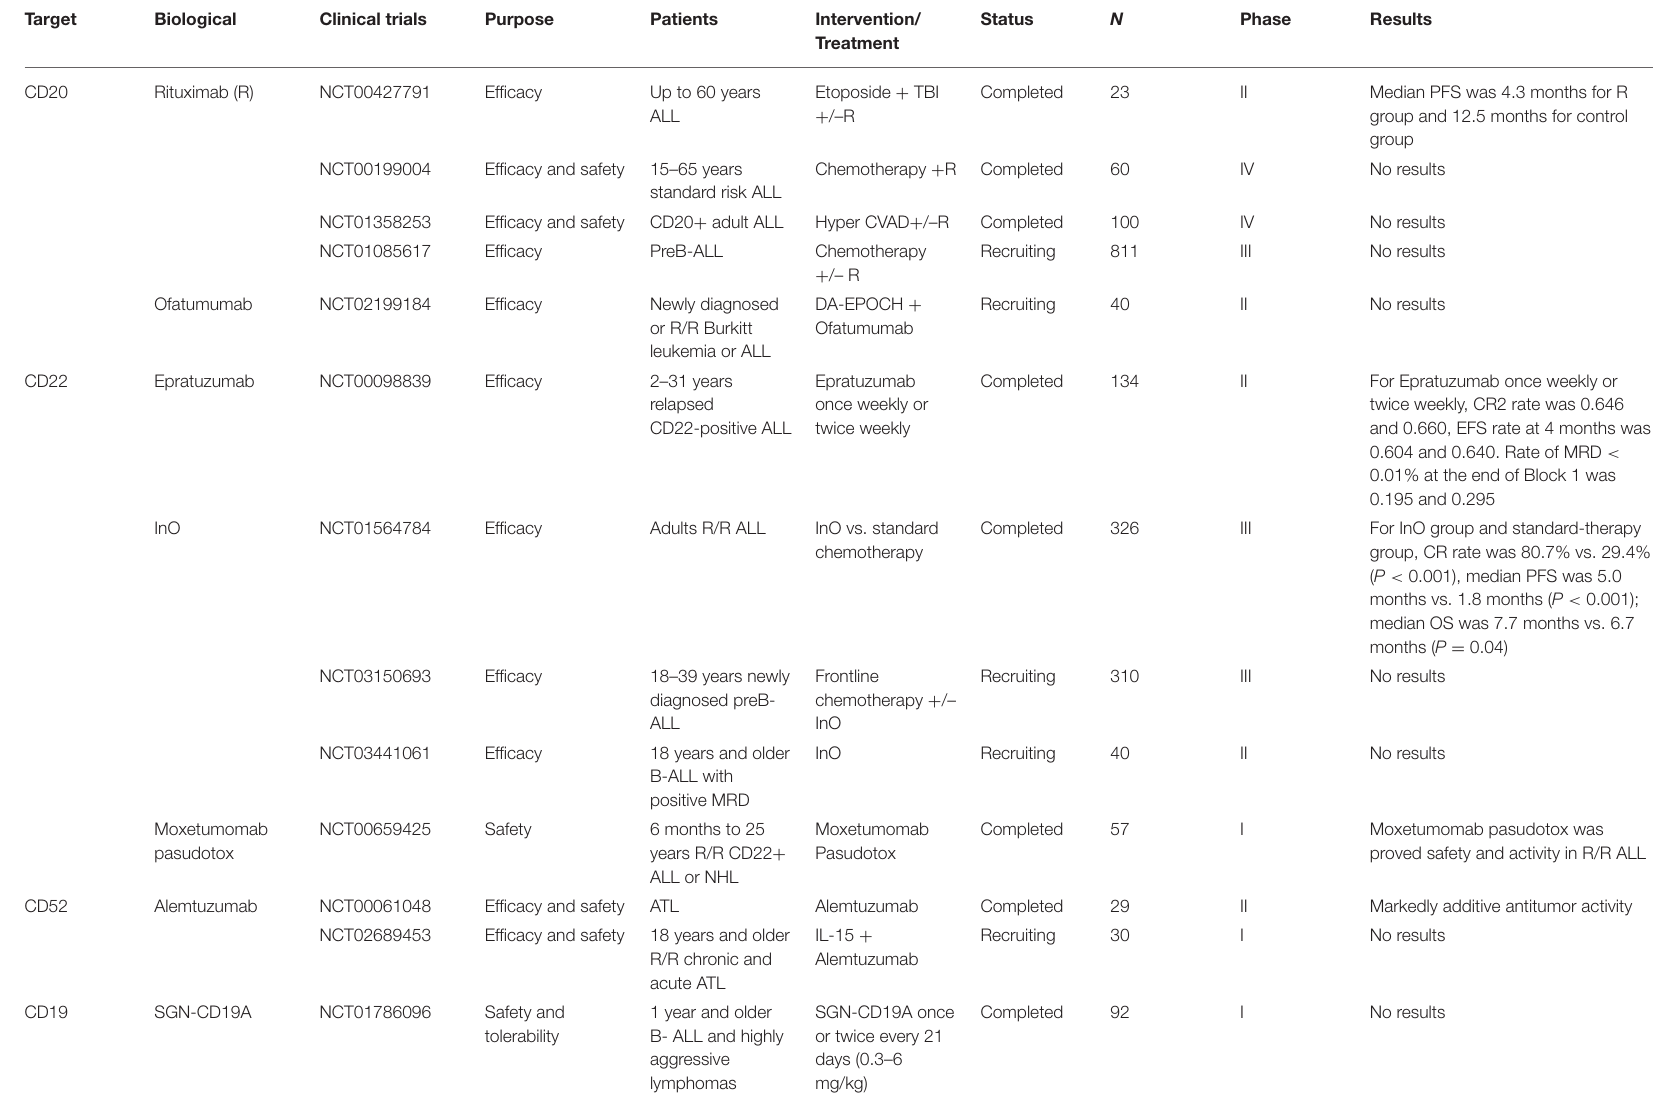
TABLE 2 | Selected completed or ongoing trials of antibody directed therapy for